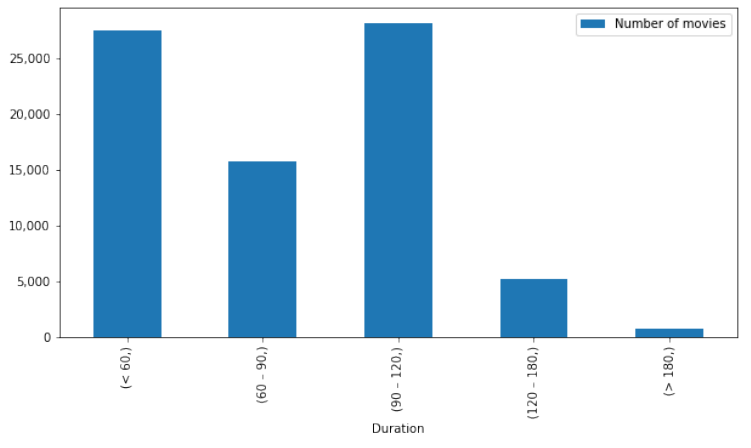
Figure 2. Movie duration distribution. Furthermore, in Figure 3, the distribution of movie genres is shown.